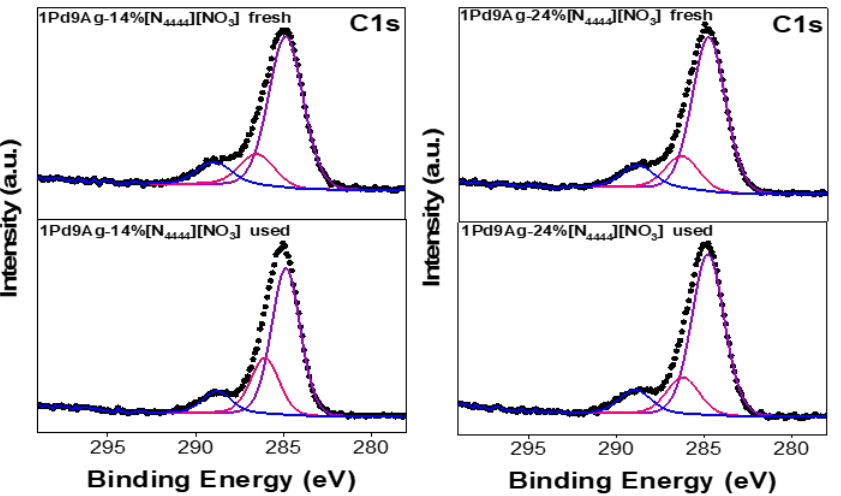
Figure 12. C 1s XP spectra for the fresh and used [N 4444 ][NO 3 ]-coated catalysts. Solid black curves represent the raw data. Fitted individual components are also shown by solid-coloured curves.